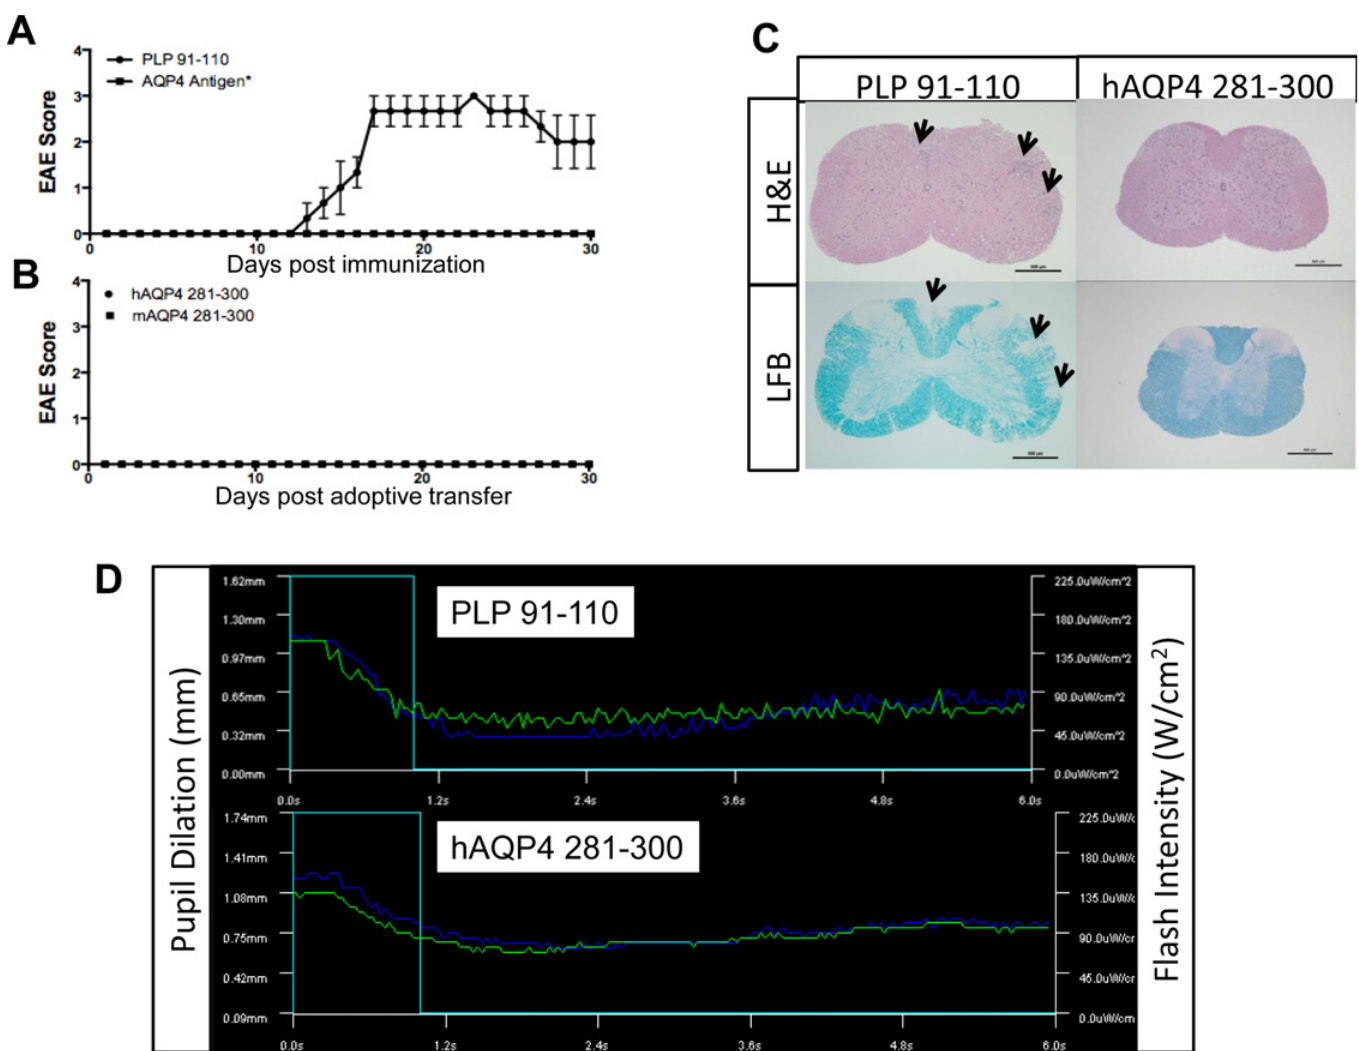
Fig 2. HLA-DRB1 * 03 : 01 transgenic mice are disease resistant to active immunization with human aquaporin 4 (hAQP4), and adoptive transfer of hAQP4-specific T cells. (A) HLA-DRB1 * 03 : 01 mice were actively immunized with proteolipid protein (PLP) 91-110 (100 μ g/100 μ l/mouse; positive control [25]), or varying AQP4 antigens * (whole-length hAQP4 protein, hAQP4 281-300 , murine (m)AQP4 281-300 , hAQP4 281-300 with a Quil-A Incomplete Freund Adjuvant (IFA) booster on day 14 post-immunization, mAQP4 281-300 with a Quil-A IFA booster on day 14 post immunization, and hAQP4 281-300 plus mAQP4 281-300 ) emulsified in Complete Freund Adjuvant (CFA). Immunization with a positive control proteolipid protein (PLP) 91-110 , a dominant encephalitogenic determinant in HLA-DRB1 * 03 : 01 led to typical EAE. (B) Lymph node cells taken from HLA-DRB1 * 03 : 01 mice immunized with hAQP4 281-300 or mAQP4 281-300 were restimulated for three days and passively transferred into HLA-DRB1 * 03 : 01 mice. None of these experimental approaches resulted in clinical disease. (C) Paraffin sections were stained with haematoxlin eosin (H&E) and luxol fast blue (LFB). Representative sections of the spinal cords from PLP 91-110 and hAQP4 281-300 immunized mice are shown. On histopathological examination there were no visible signs of cellular infiltration, inflammation, or demyelination within the brain and spinal cord in any experimental paradigms other than in active immunization with PLP 91-110 , the dominant encephalitogenic determinant in HLA-DRB1 * 03 : 01 that led to typical EAE (spinal cord shown; inflammatory infiltrates and areas of demyelination are indicated by black arrows). (D) Fifteen days post immunization of HLA-DRB1 * 03 : 01 transgenic mice with PLP 91-110 or hAQP4 281-300 , pupillary reflex was measured via a mouse pupillometry. Mice actively immunized with hAQP4 281-300 and the control antigen PLP 91-110 did not show altered pupillary responses.